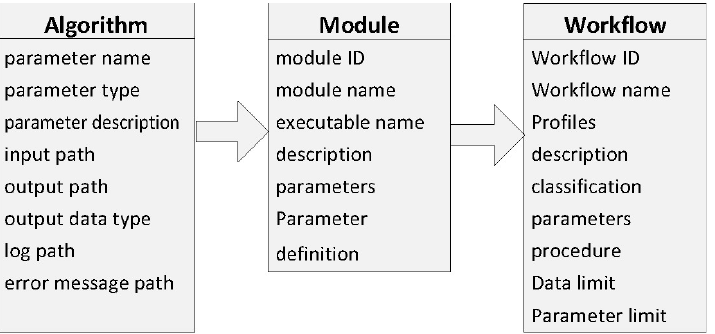
Figure 2. Business process modeling related information definition.